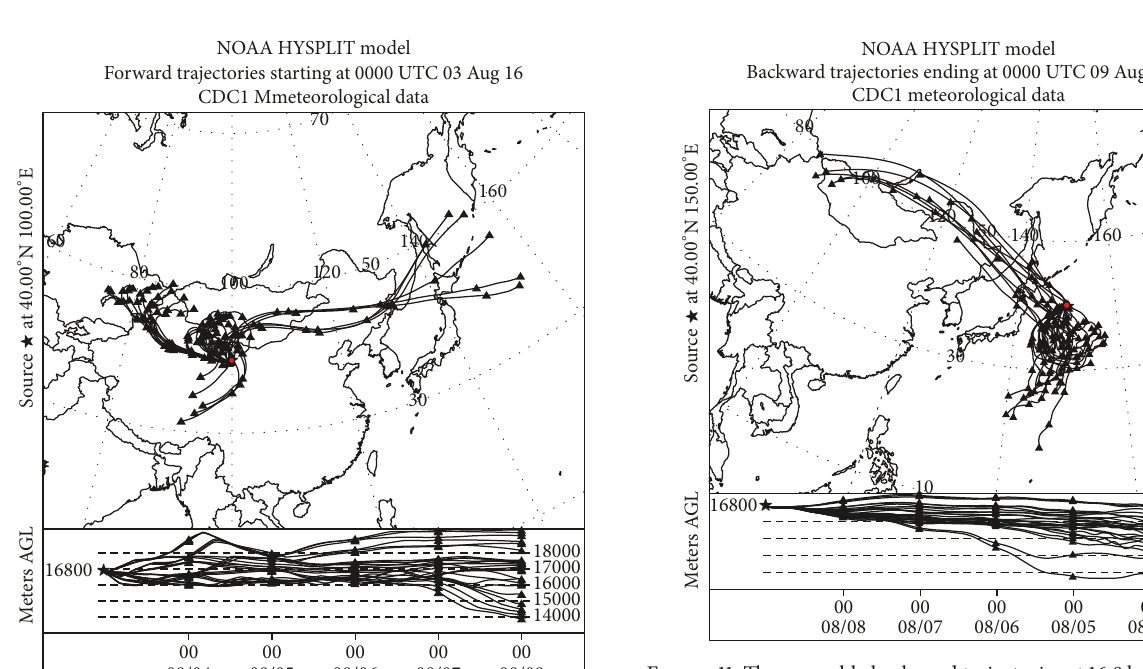
Figure 11: The ensemble backward trajectories at 16.8 km on Aug 9, 2016. The trajectory released at 40 ∘ N, 150 ∘ E (red dot). The duration is 120